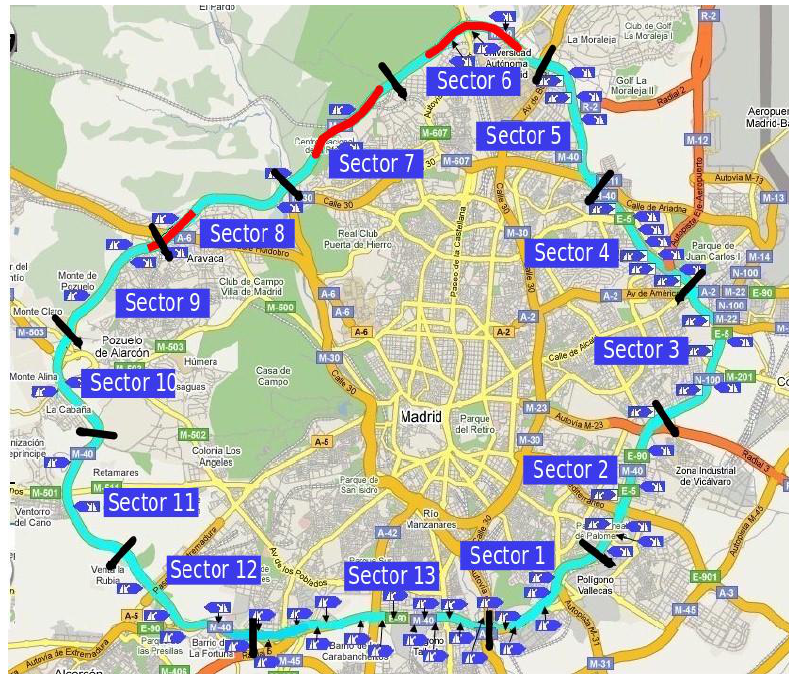
Figure 8. The M40 (Madrid, Spain).